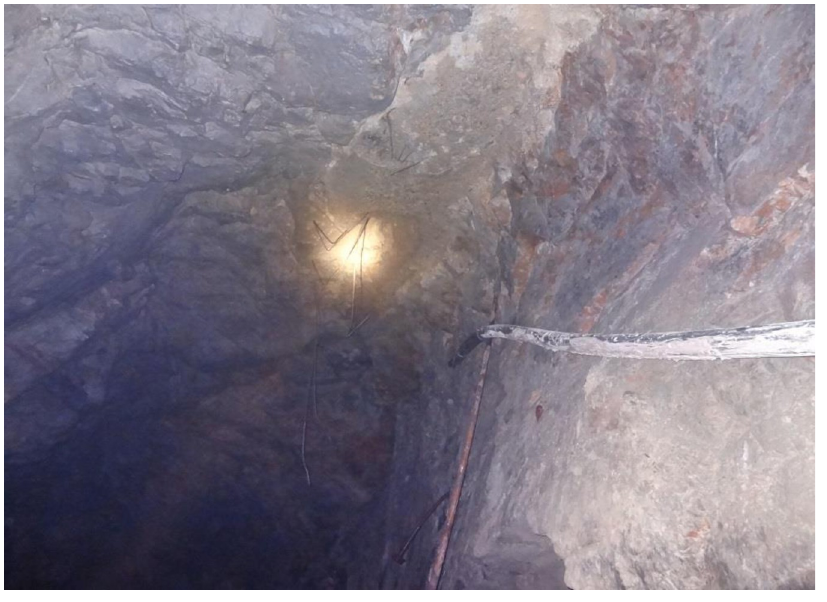
Fig 1. Photograph of the stope